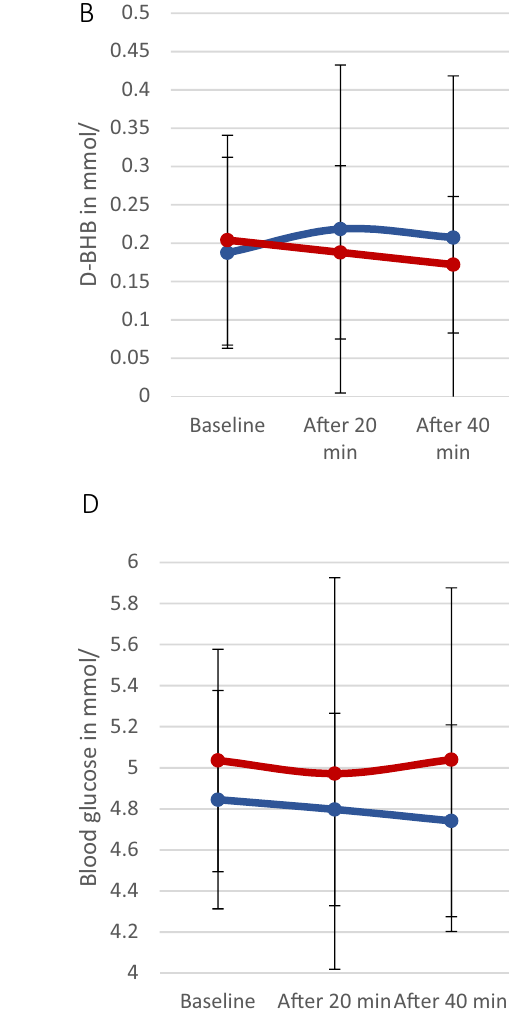
Figure 1. Blood BHB and glucose levels with IMP (panels ( A ) and ( C )) placebo (panels ( B ) and ( D )) in non- responders (blue) & responders (red). Error bars depict the standard deviation